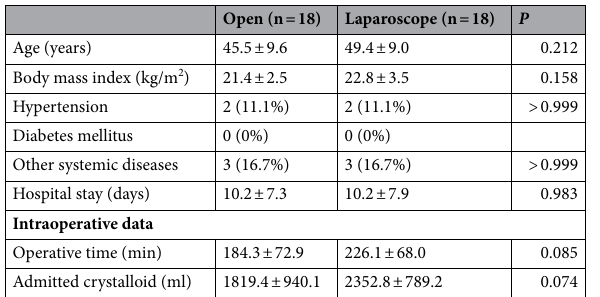
Table 1. Demographic and perioperative characteristics of the study patients. Data are expressed as mean ± standard deviation or number (percentage).